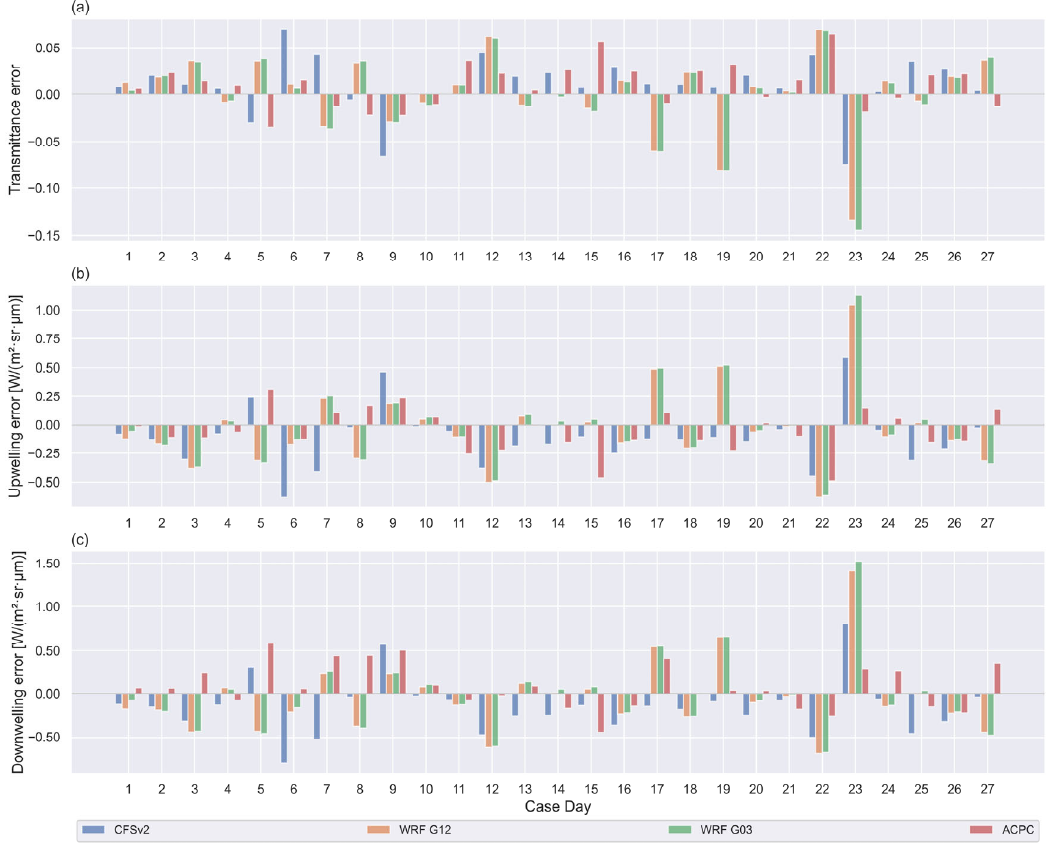
Figure 4. Errors in the estimation of ( a ) atmospheric transmittance, ( b ) upwelling radiance, and ( c ) downwelling radiance from the different profiles for each case day.